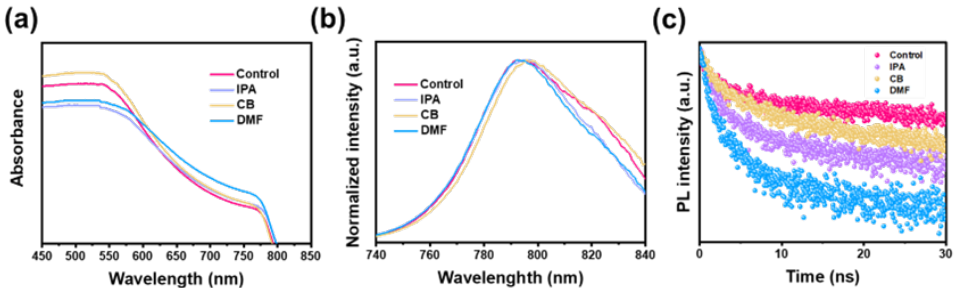
Figure 4. Optical properties of perovskite films under control, IPA, CB and DMF solvent vapor conditions, respectively. ( a ) UV-vis absorption results. ( b ) Steady-state photoluminescence results. ( c ) Time-resolved photoluminescence results. All perovskite films were prepared on PTAA-coated ITO glass. Table 1. The data for fitted TRPL curves.